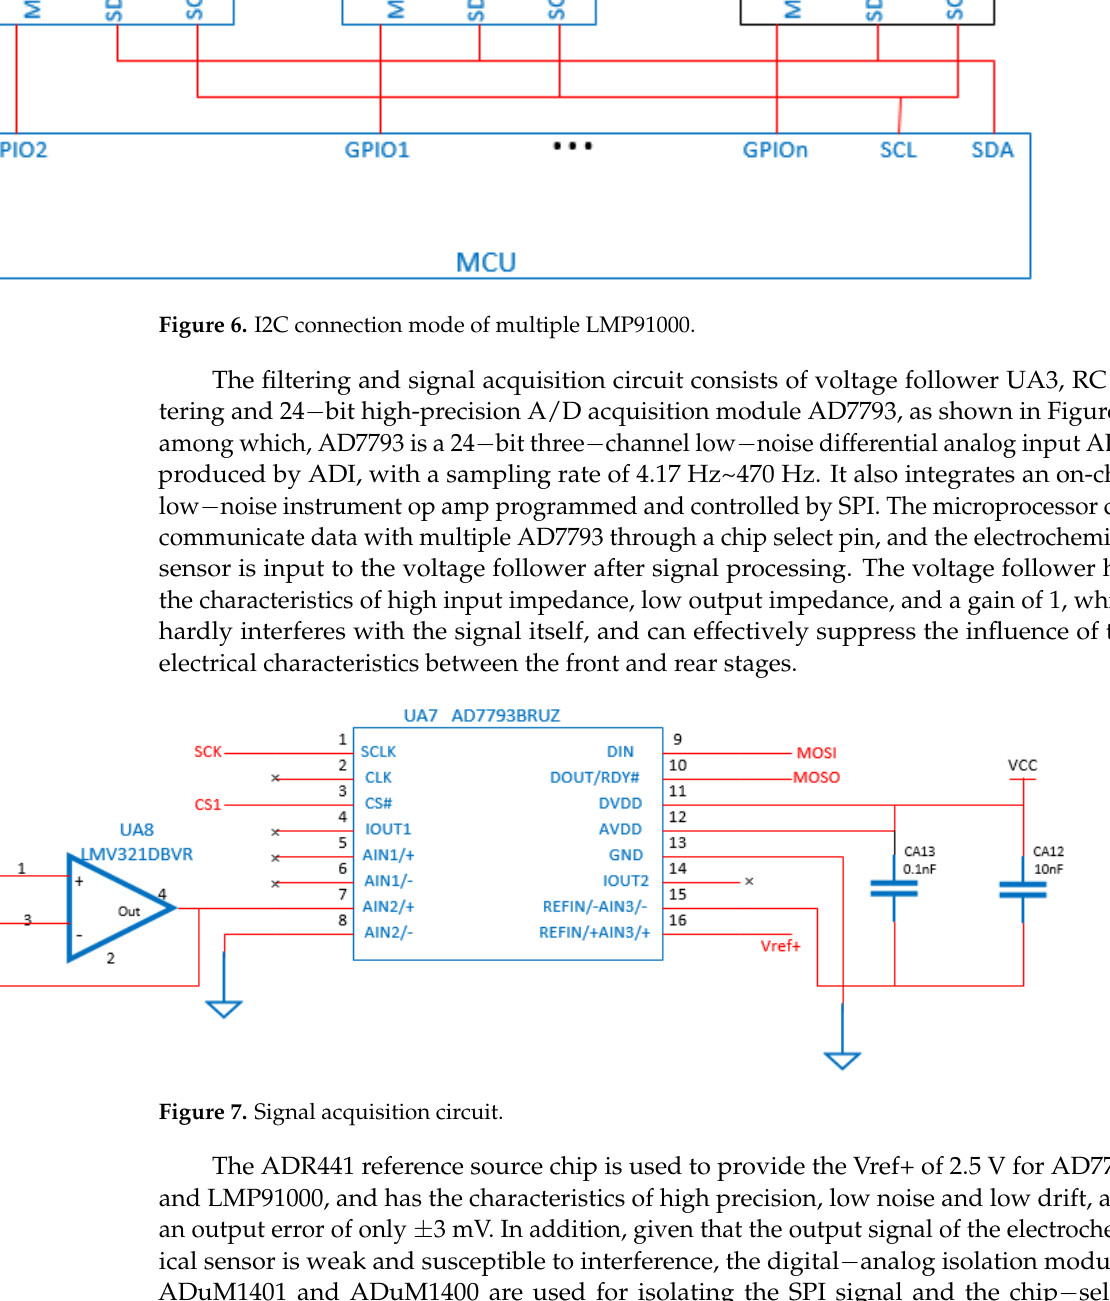
Figure 6. I2C connection mode of multiple LMP91000.